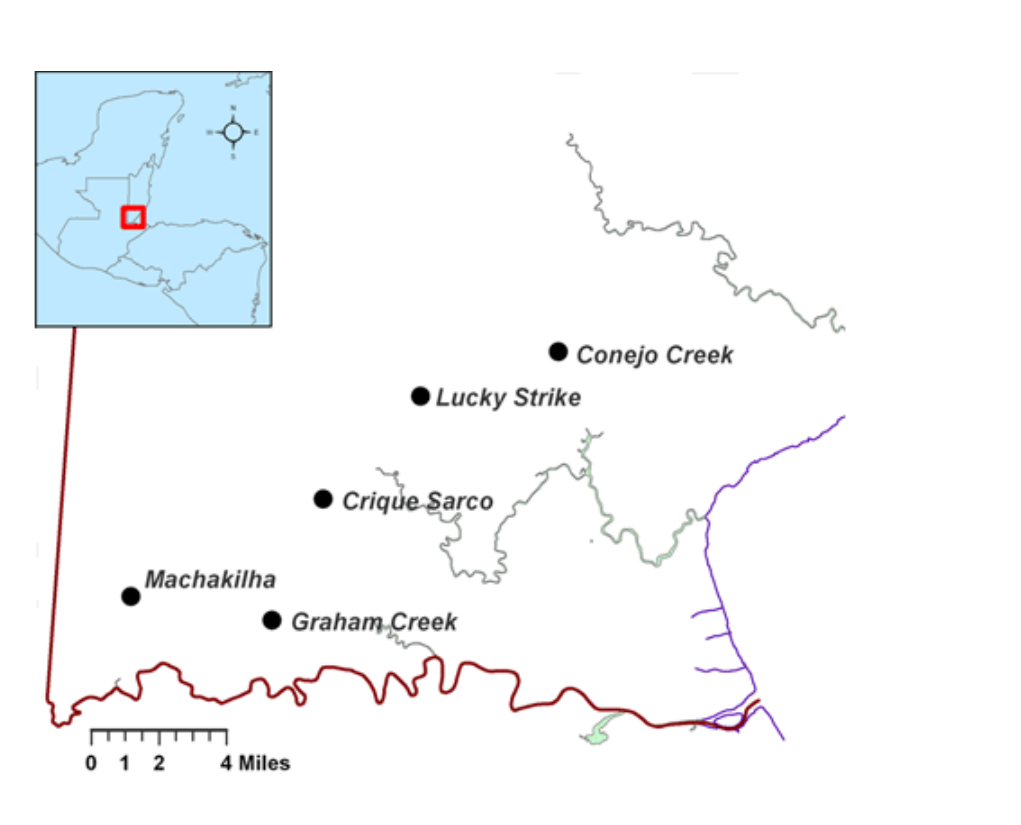
Fig. 1. The study site in southern Belize, Central